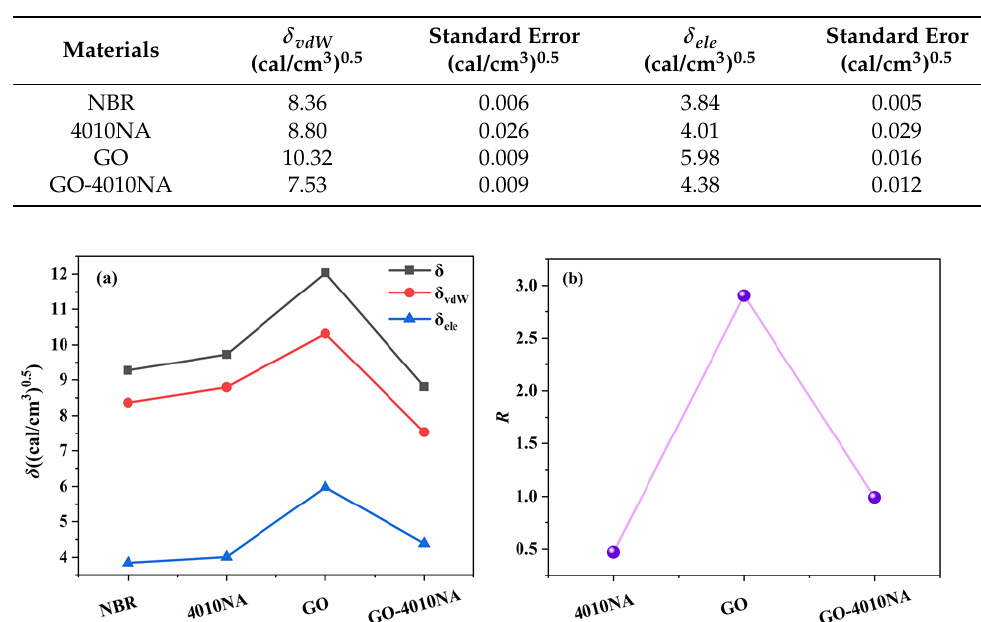
Table 4. Charges and forced field type of the atoms. Polar Functional Groups